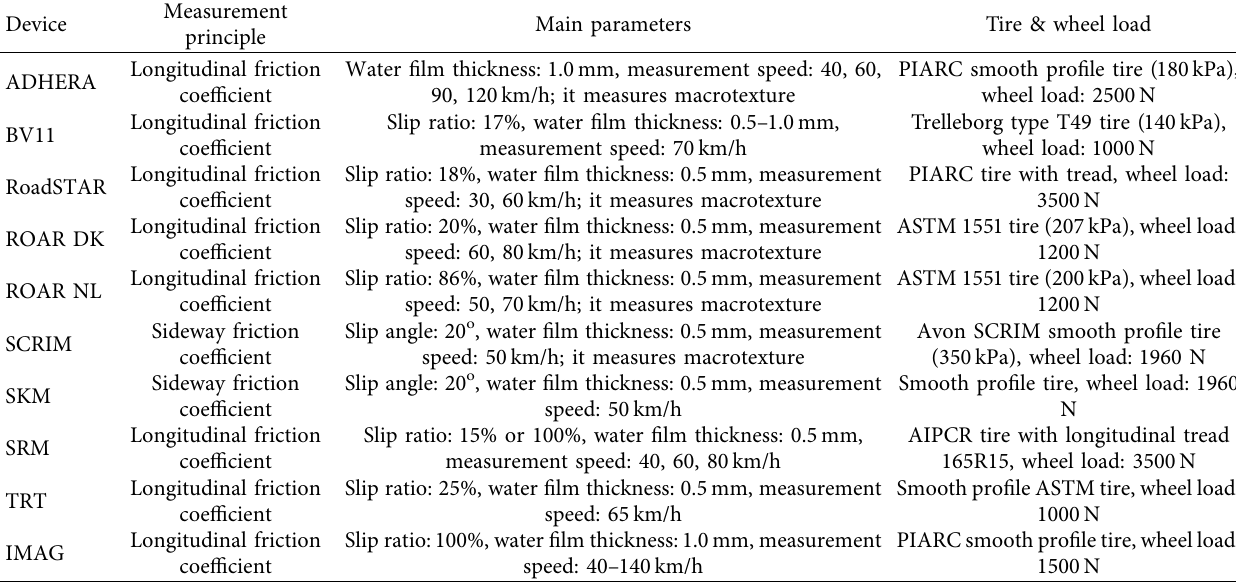
Table 2: Summary of skid resistance measuring devices in the field